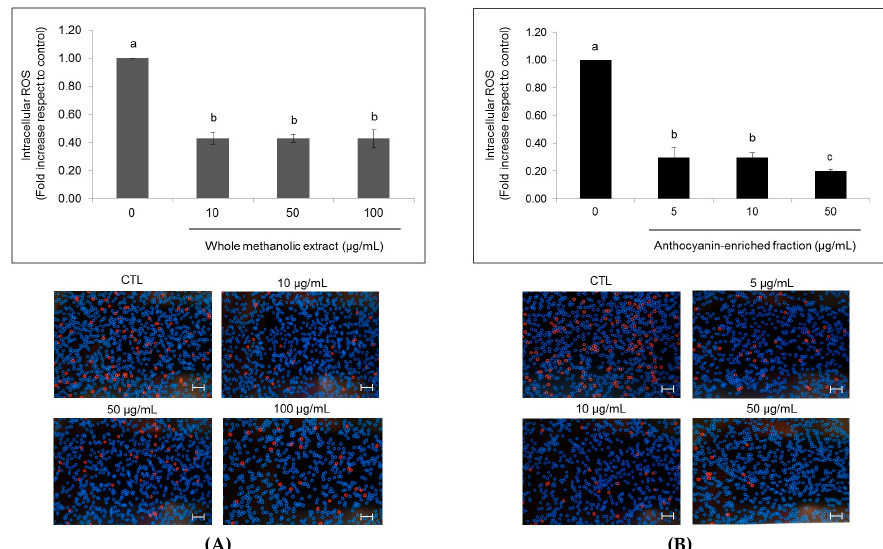
Figure 4. Effects of strawberry whole methanolic extract ( A ) and the anthocyanin-enriched fraction ( B ) on intracellular reactive oxygen species (ROS) production in HepG2 cells. Cells were treated with the indicated concentration of strawberry extracts for 24 h. The concentration of 0 µg/mL corresponds to the control (untreated cells). Scale bar, 50 µm. Representative images of intracellular ROS quantification by the Tali ® Image-Based Cytometer (Thermo Fisher Scientific, Milan, Italy) are shown following the graphs (stressed cells appear red). Values are expressed as the mean ± SD of three independent experiments ( n = 3). Columns belonging to the same set of data with different superscript letters are significantly different ( p < 0.05).